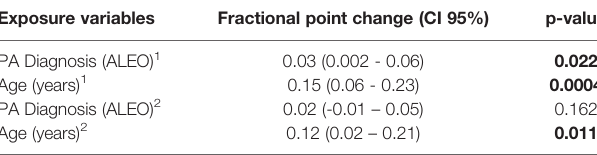
TABLE 3 | Modi fi ers of TLR2 promoter ’ s methylation status.